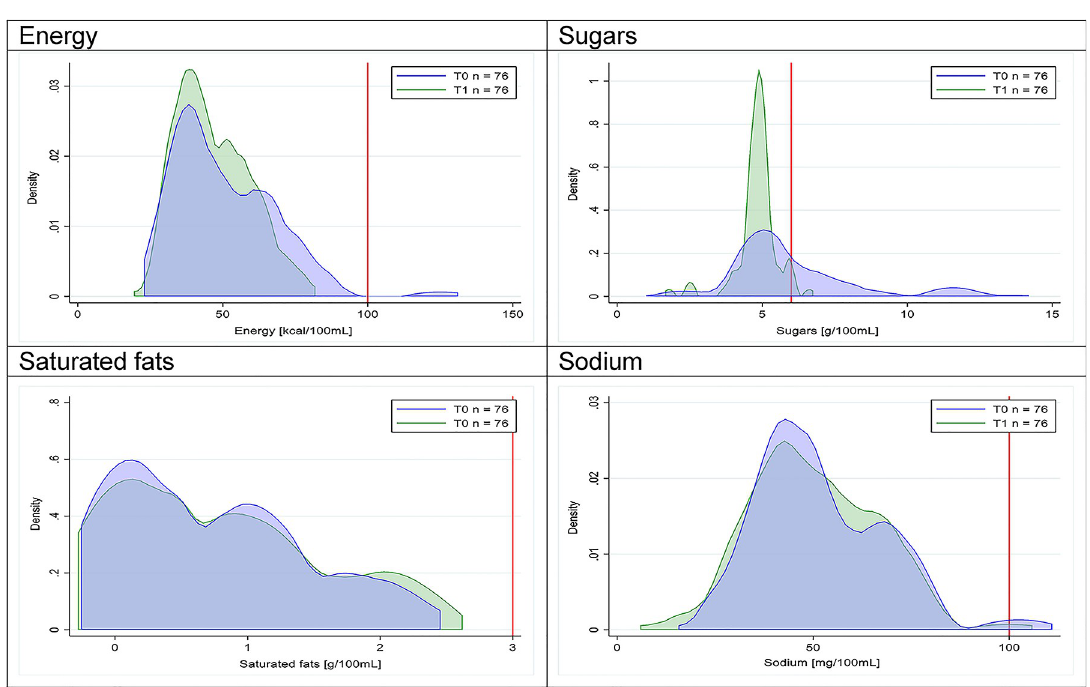
Fig 19. . Density curves for the amount of energy and nutrients of concern in milk and milk-based drinks, longitudinal subsample. The blue line represents the distribution in T0 (preimplementation), the green line represents the distribution in T1 (postimplementation), and the red line represents the cutoff for the amount of energy or nutrients of concern.